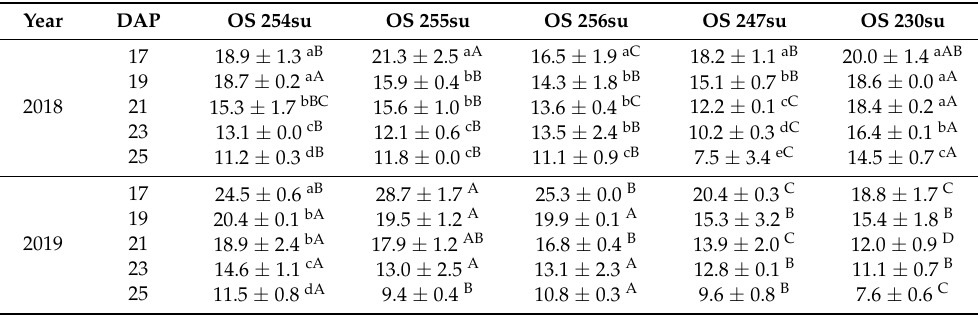
Table 3. Kernel total sugars content (mg/g DW) in five su1 sweet corn hybrids at five harvest dates (17–25 DAP) in two growing seasons (Osijek, 2018 and 2019). The different lowercases show significant differences among the harvest dates within hybrids ( p < 0.05). The different capital letters show significant differences among the hybrids ( p < 0.05).